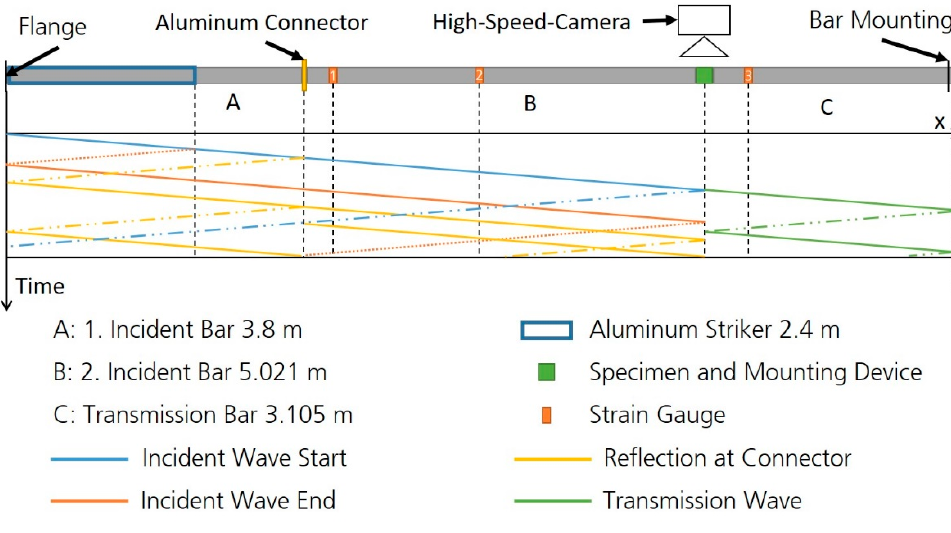
Figure 3. The SHTB configuration with an idealized Lagrange diagram.